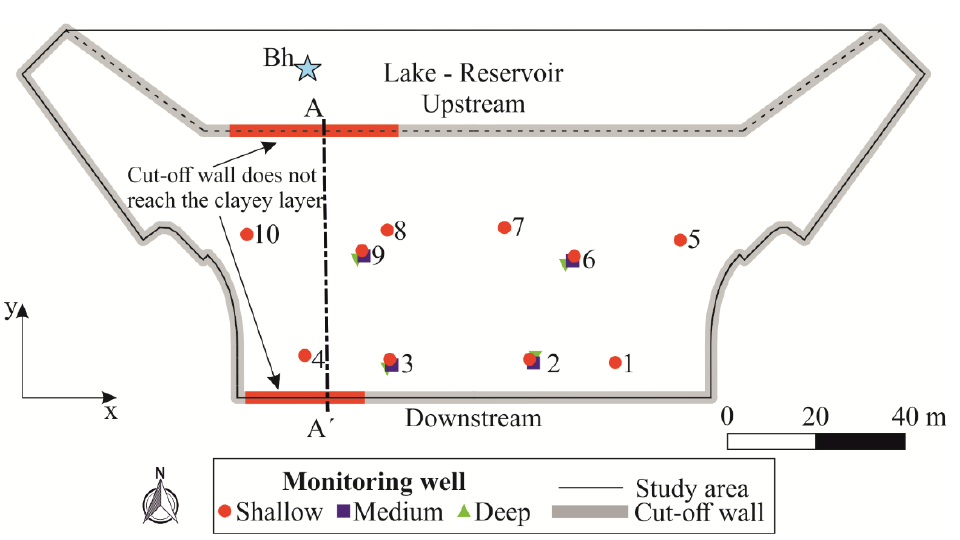
Figure 1. Top view of the study area: Location of the monitoring wells and of the cross-section AA’ of Figure 2. The cyan star denotes the position of the borehole Bh.